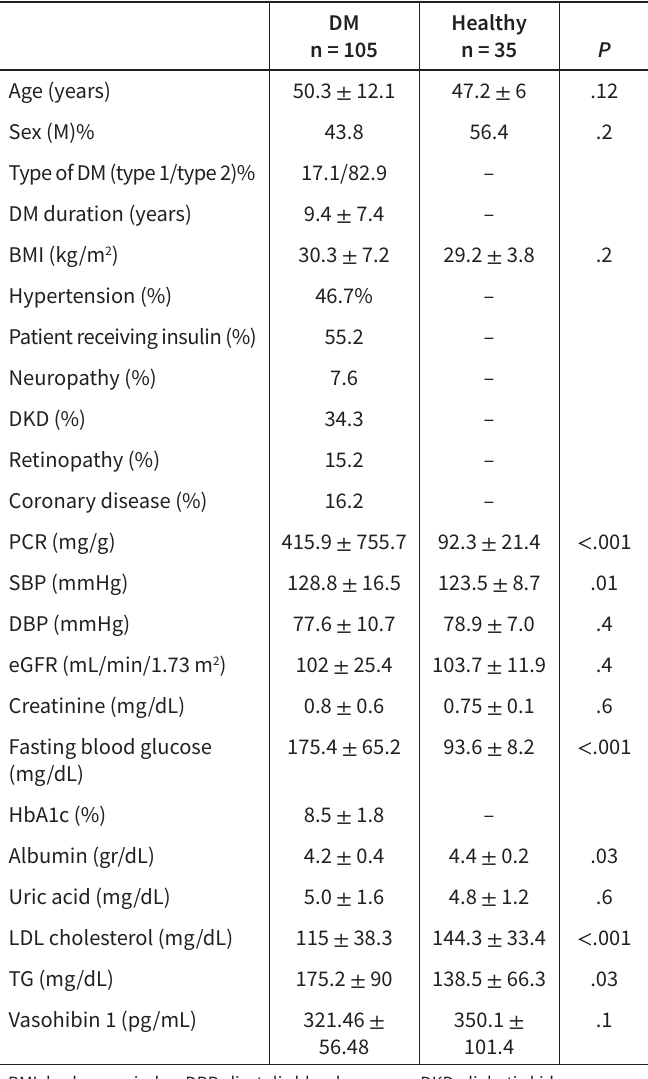
Table 1. Comparison of Diabetic and Healthy Patients